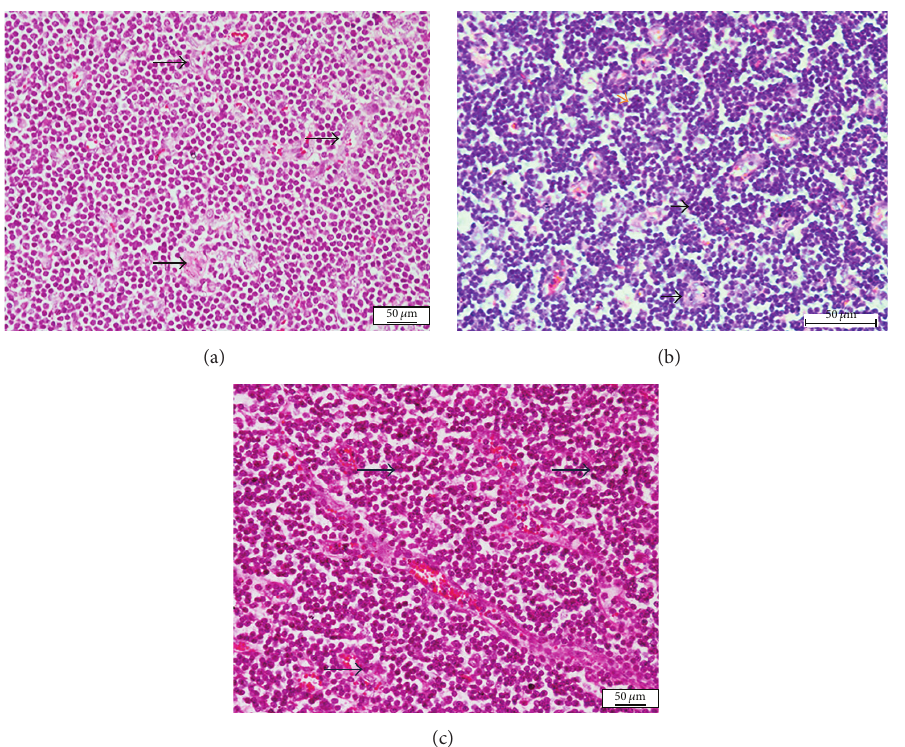
Figure 3: Photomicrograph section of the lymph node of nonpregnant does inoculated with Corynebacterium pseudotuberculosis : Note (a) the neutrophil infiltration and microabscesses with a central necrotic areas (black and orange arrows), following intranasal inoculation; (b) inflammatory cell infiltration characterized by neutrophils and macrophages (black arrows), congestion (blue arrow), following oral inoculation;(c)neutrophilinfiltrationandmicroabscesseswithcentralnecroticareas(blackarrows),followingintradermalinoculation(H&E × 400).